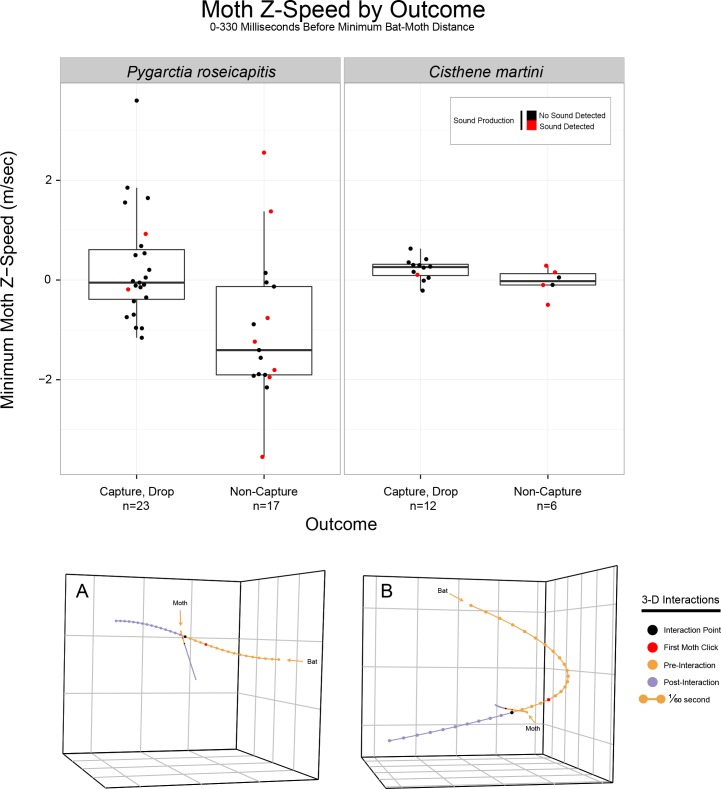
Moth z-speed between “Capture, Drop” and “Non-Captured” outcomes among tymbaled (T+ and S groups) moths for Pygarctia roseicapitis and Cisthene martini.Boxplot follows plotting conventions in Fig 3. The speed of the moths in the z-axis acts as a proxy for detecting diving evasive behavior. Positive values are upward flight, values near 0 m*sec-1 are level flight, and negative values are downward flight. Only P. roseicapitis which were not captured were significantly different from 0 m*sec-1, indicating that that species employed evasive dives. Neither outcome involving C. martini was significantly different from 0 m*sec-1, indicating that this species did not frequently employ evasive dives. 3-D perspective plots display representative flight path data. Bats are depicted as larger points and moths as smaller points. Starting points are indicated by an arrow. Time flows from Yellow (Pre-Interaction) > Black (Interaction) > Purple (Post-Interaction). Black points are the closest distance between bat and moth and red points indicate when the moth was first detected to click. (A) “Non-Captured” P. roseicapitis diving (negative moth z-speed) in response to a bat attack. (B) “Non-Captured” C. martini taking no evasive action (moth z-speed ≈ 0) in response to a bat attack. Neither bat turned away from the clicking moth nor did they enact typical prey capture behaviors.